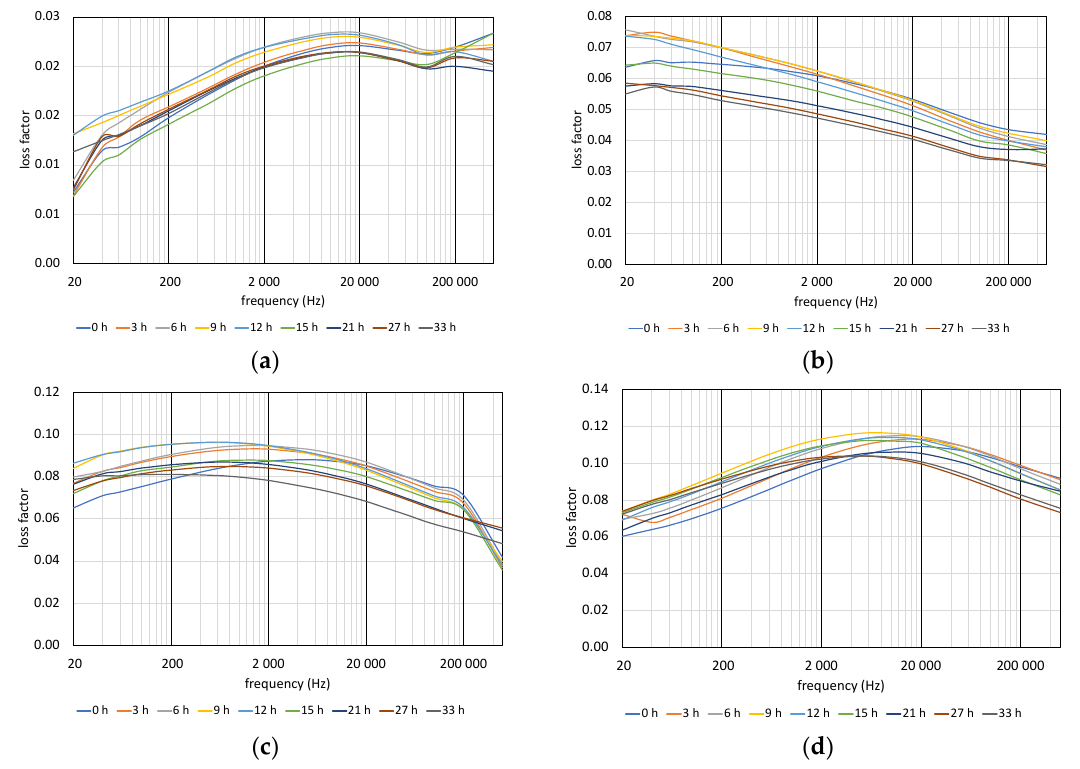
Figure 11. Changing of loss factor with aging time of PVC films: ( a ) DOP0, ( b ) DOP30, ( c ) DOP40, and ( d ) DOP50.